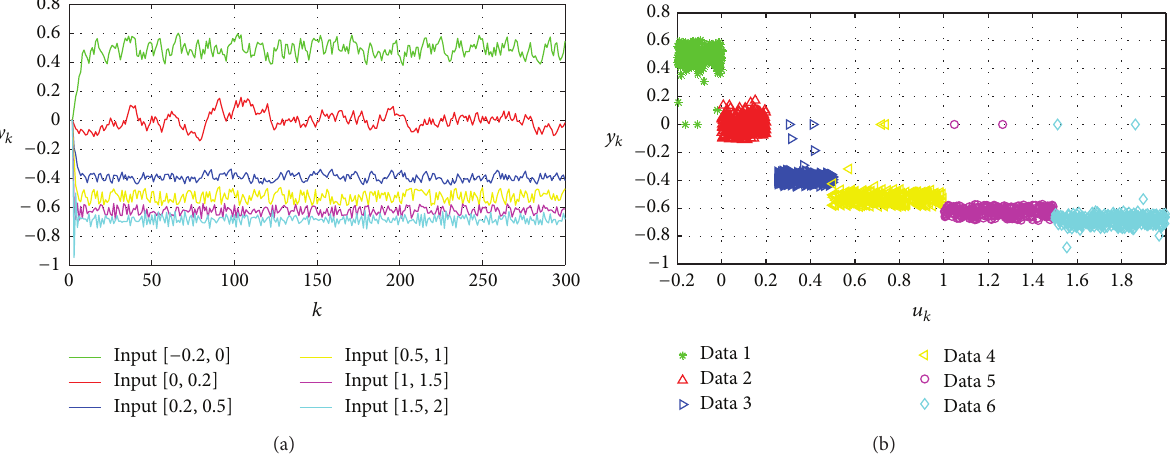
Figure 6: Data set. (a) Output results with different input data. (b) Different ranges of input values and the corresponding output values concentrate in a single